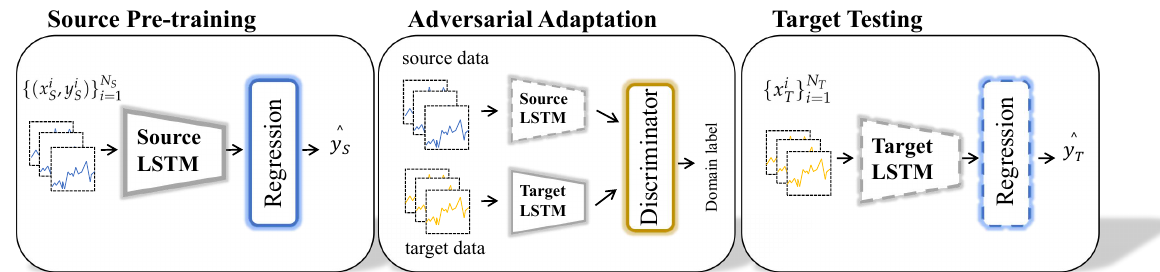
Figure 4. An overview of the adversarial discrimination domain adaptation method based on LSTM (LSTM-ADDA). Stage I: Supervised learning of source domain training data and source domain testing data for degradation pattern extraction. Stage II: Adversarial learning of source domain training data and target domain training data for domain-invariant feature extraction. Stage III: RUL prediction and result evaluation of target domain testing data. Dashed lines indicate fixed network